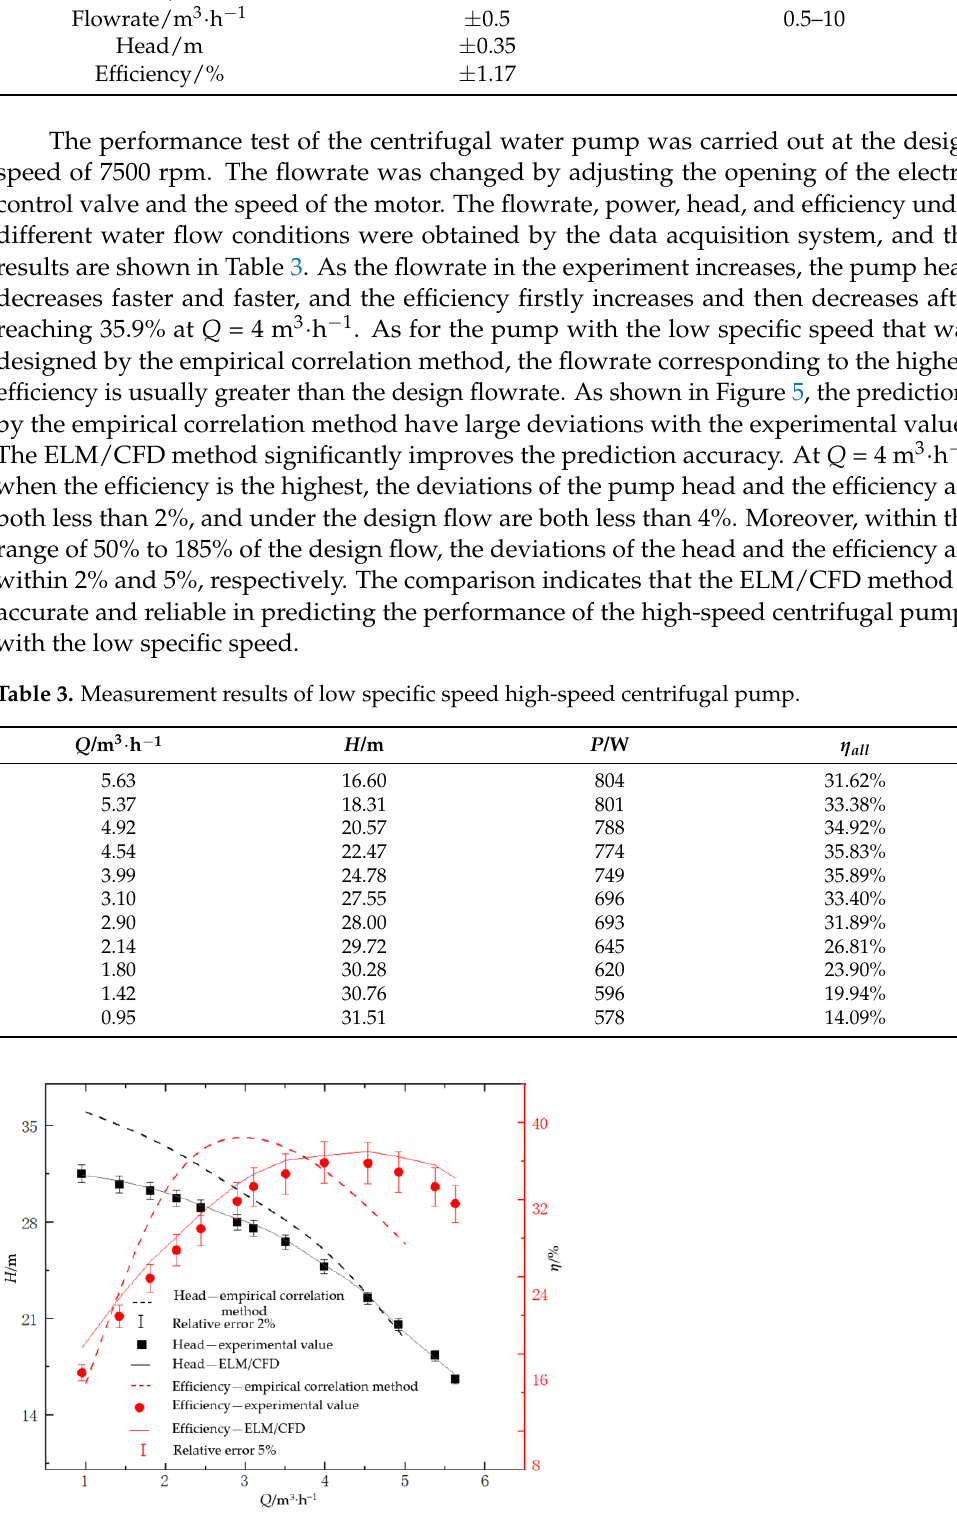
( b ) Figure 6. Pressure distribution of centrifugal pump fluid along streamline. ( a ) Total pressure distri- bution of centrifugal pump fluid along streamline; ( b ) static pressure distribution of centrifugal pump fluid along streamline. After the fluid enters the area with blades, the pressure rises rapidly and it fluctuates after rising at the junction of the impeller and the vaned diffuser, as shown in Mark 2 in Figure 6. This is because there is the reflux and hub leakage between the impeller and the